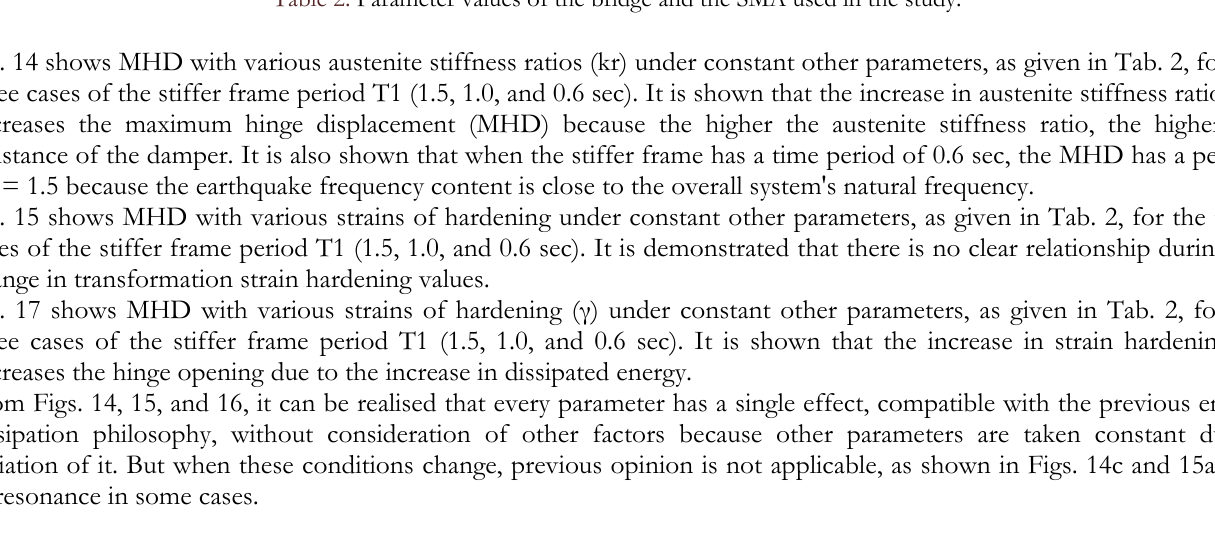
Table 2: Parameter values of the bridge and the SMA used in the study.